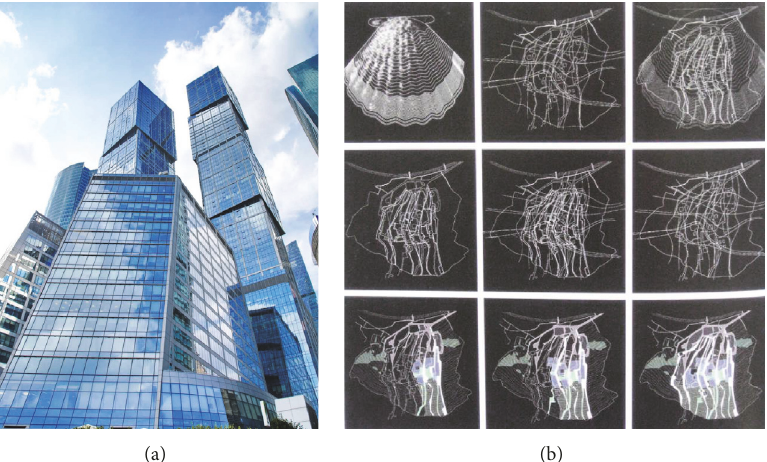
Figure 2: (a) City of Capitals in Moscow IBC, Russia. (b) Diagram of City of Culture of Galicia, Santiago de Compostela, Spain, by Peter